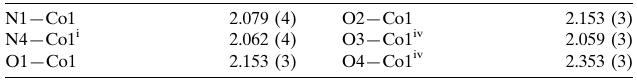
Selected geometric parameters (A˚ , (cid:5) ).